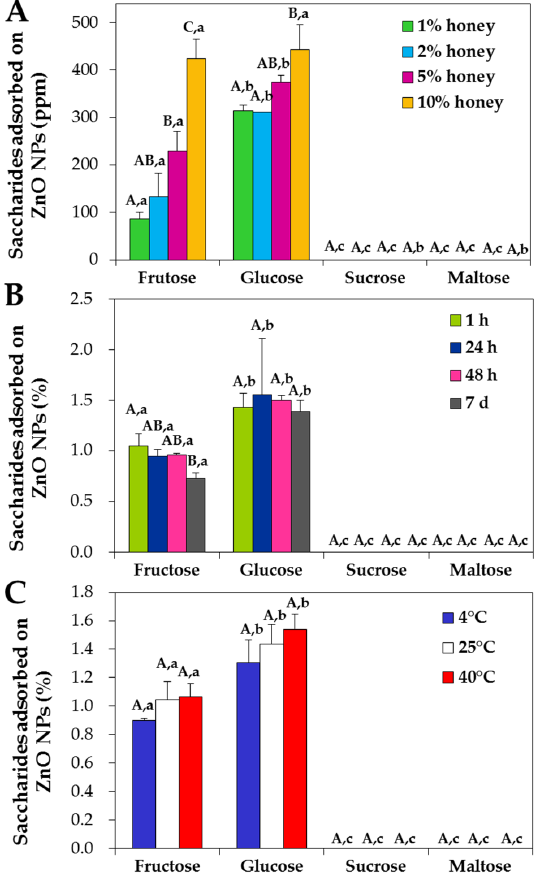
Figure 6. High performance liquid chromatography (HPLC) analysis of the interactions between ZnO NPs and saccharides in acacia honey with respect to ( A ) honey concentrations after incubation for 1 h at 25 °C, ( B ) incubation time in 10% honey at 25 °C and ( C ) temperature after 1 h in 10% honey. Different capital letters (A–C) indicate significant differences in adsorbed amounts of each saccharide ( A ) between honey concentrations, ( B ) between incubation times and ( C ) between temperatures, respectively ( p < 0.05). Different lower-case letters (a,b) indicate significant differences between saccharide types ( A ) at the same concentration, ( B ) after the same incubation time and ( C ) at the same temperature, respectively ( p <